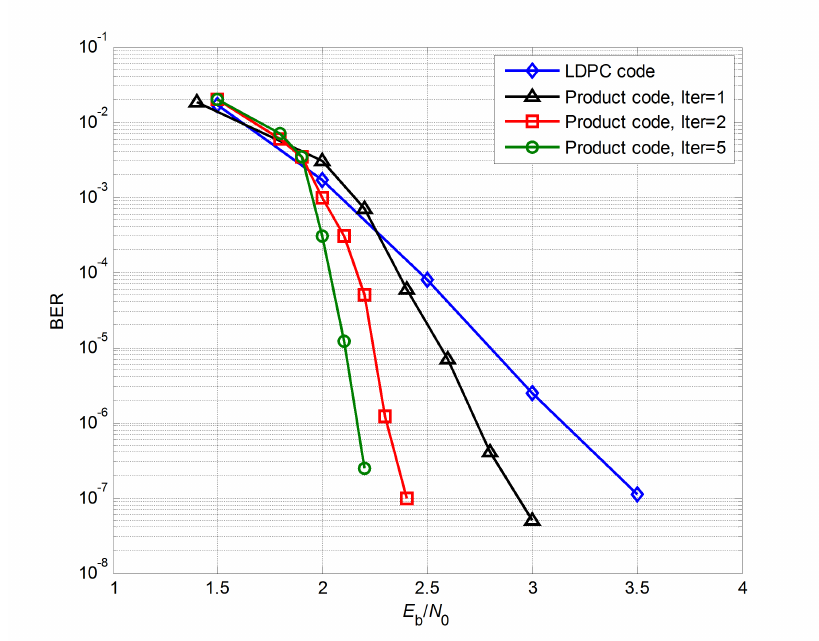
Figure 15. FPGA evaluation results of product codes with LDPC (576, 288) and Hamming (1023,